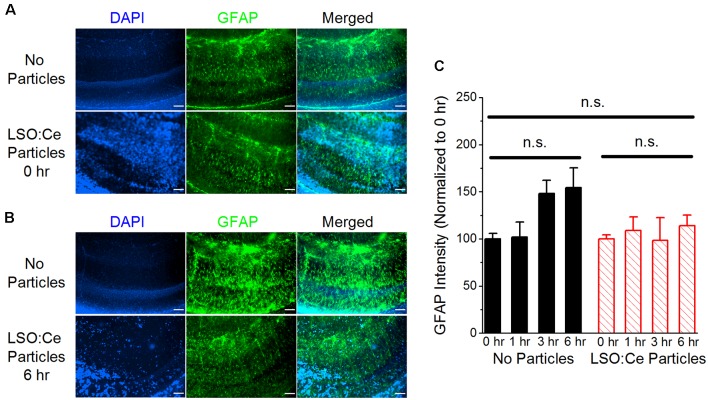
Exposure of LSO:Ce microparticles to acute hippocampal slices does not elevate glial fibrillary acidic protein (GFAP). (A) Example images of GFAP staining in acute hippocampal slices immediately after application of vehicle (no particles) or LSO:Ce particles. Merged images include 4′,6-diamindino-2-phenylindole dihydrochloride (DAPI; blue) and GFAP (green) staining. Scale bars: 100 μm. (B) Example images of GFAP staining in acute hippocampal slices 6 h after application of vehicle or LSO:Ce particles. Merged images include DAPI (blue) and GFAP (green) staining. Scale bars: 100 μm. (C) Group data shows that the intensity of GFAP staining is not altered with the addition of the LSO:Ce particles (n = 8 slices/4 animals per condition, two-way ANOVA, F(3,63) = 1.76, p = 0.17). n.s, not significant.